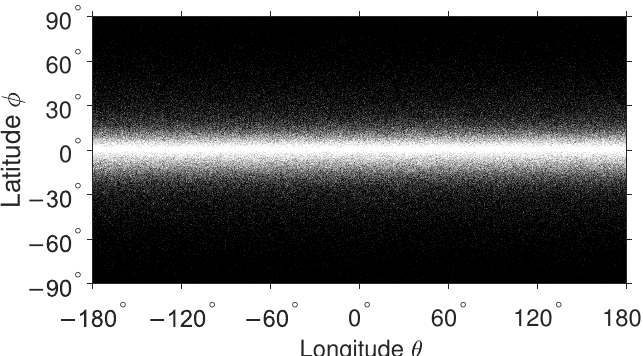
Figure 9. Binary map of random data hiding positions along the latitude (Black: Pixel used for data hiding; White: Pixel not used for data hiding).